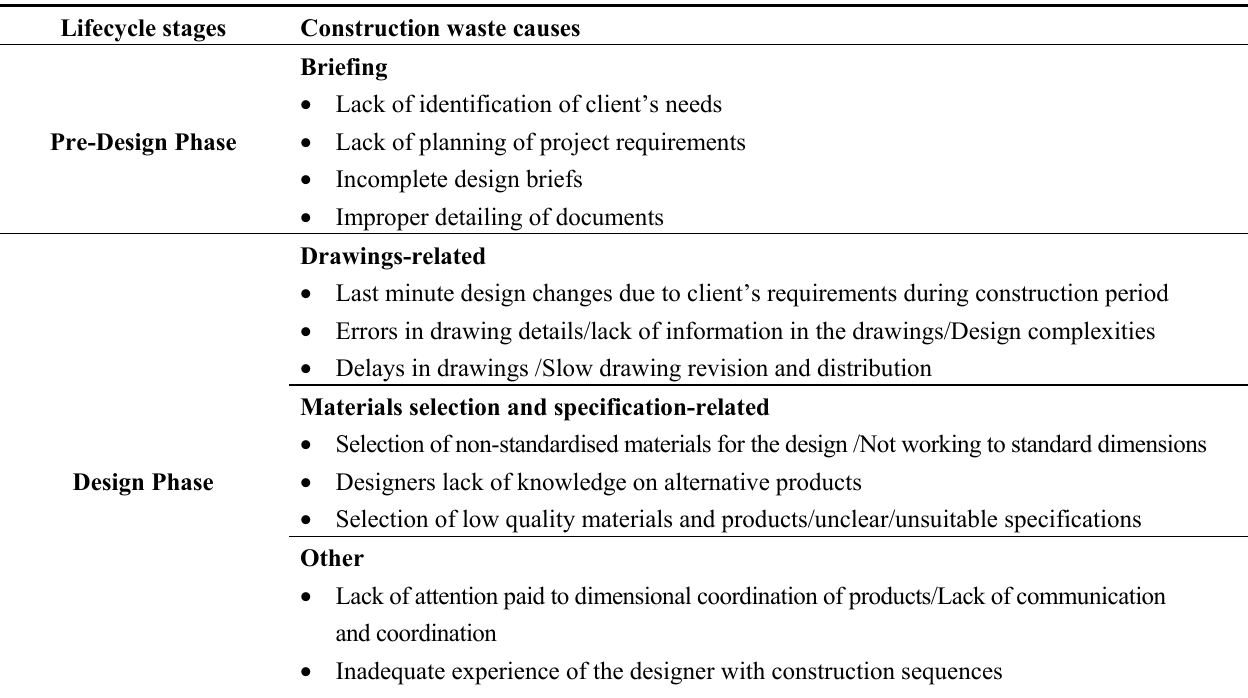
Table 1. Causes of waste in a project life cycle (Compiled from